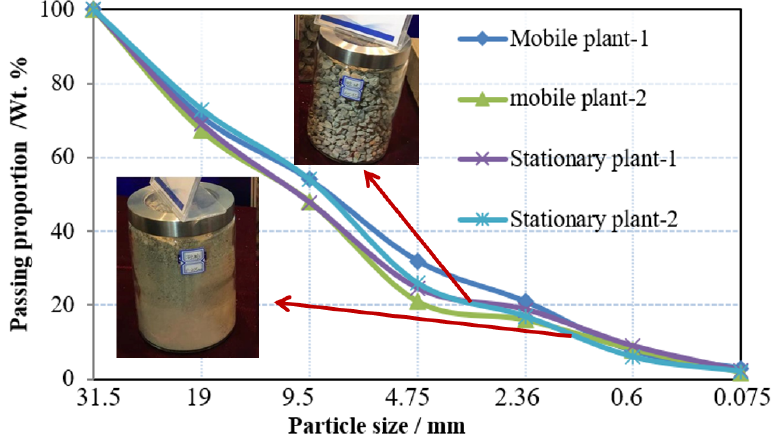
Figure 17. Particle size distribution of crushed materials for mobile plant and stationary plant.